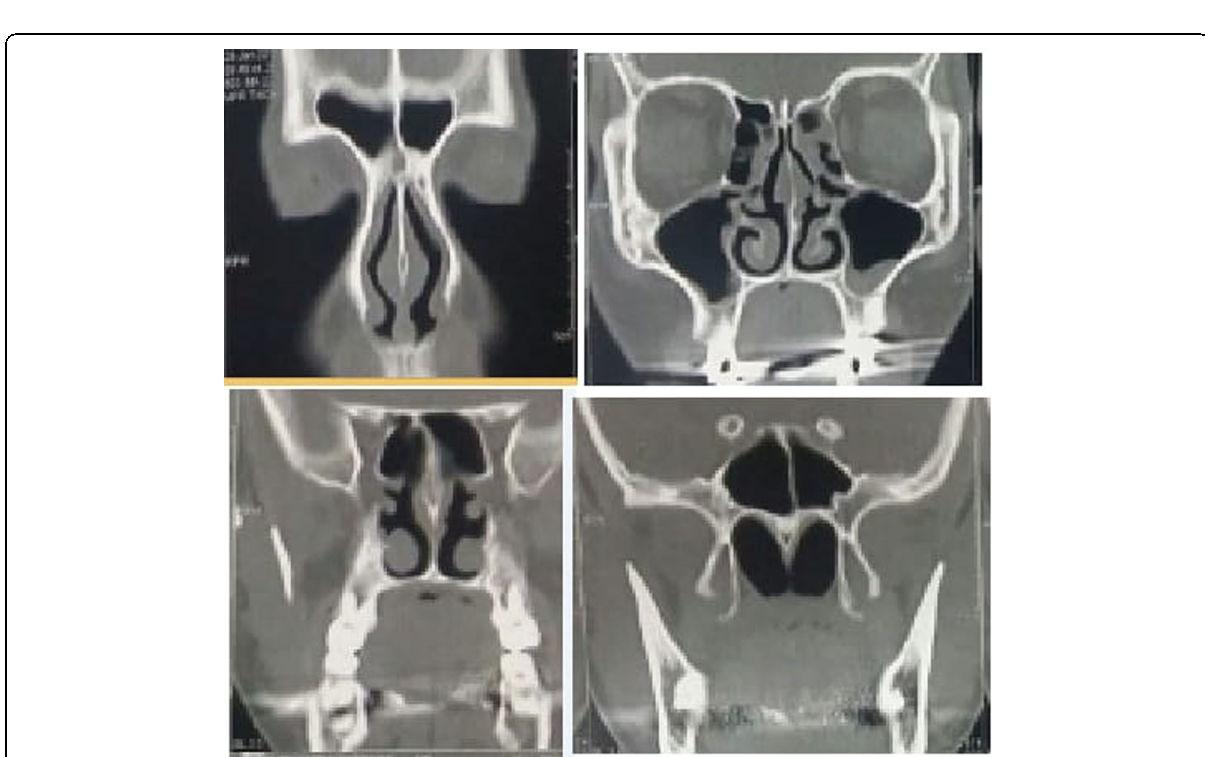
Fig. 6 CT PNS of the same patient after reciveing 3 intrapolyp steroid injection, showing complete regression of nasal